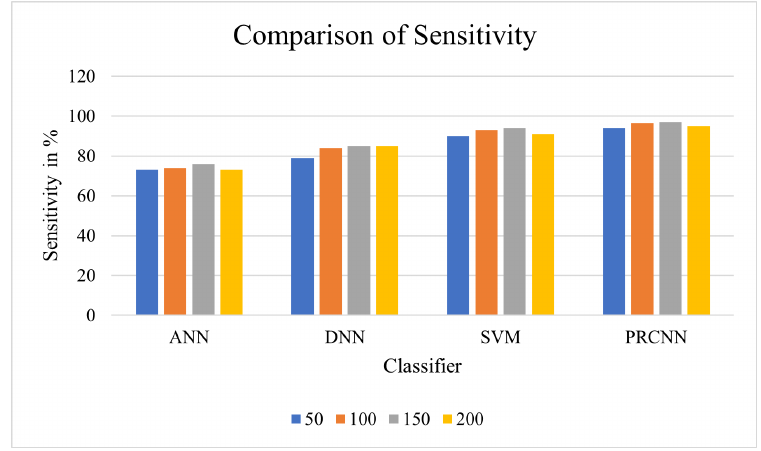
Figure 8. Comparison of sensitivity.